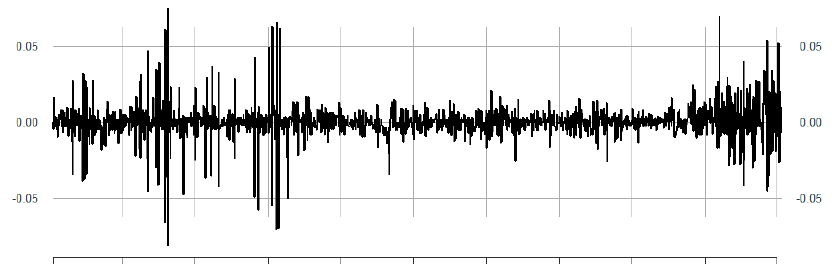
Figure 6. PJM Western Hub Peak log return series plot.